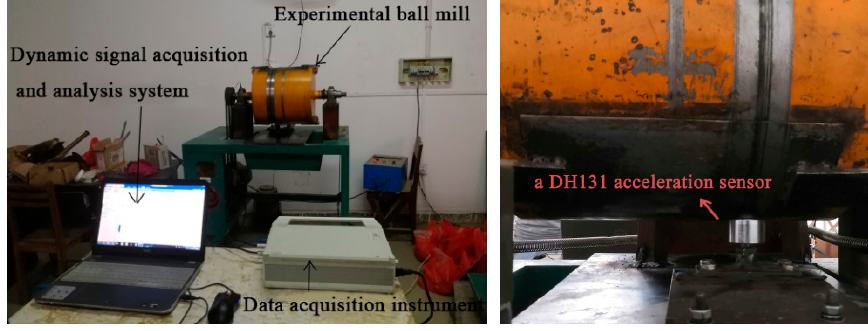
Figure 7. Experimental device.